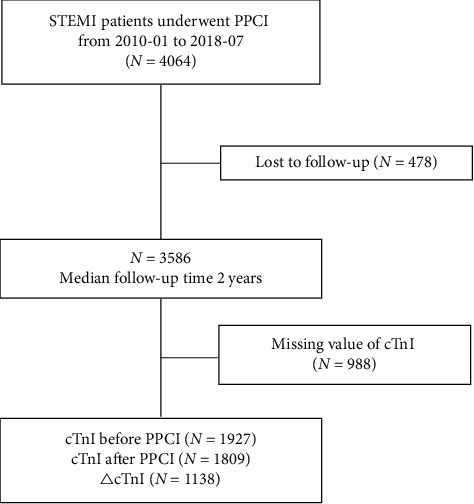
Flow chart of study enrollment. cTnI, cardiac troponin I; PPCI, primary percutaneous coronary intervention; STEMI, ST-segment elevation myocardial infarction.